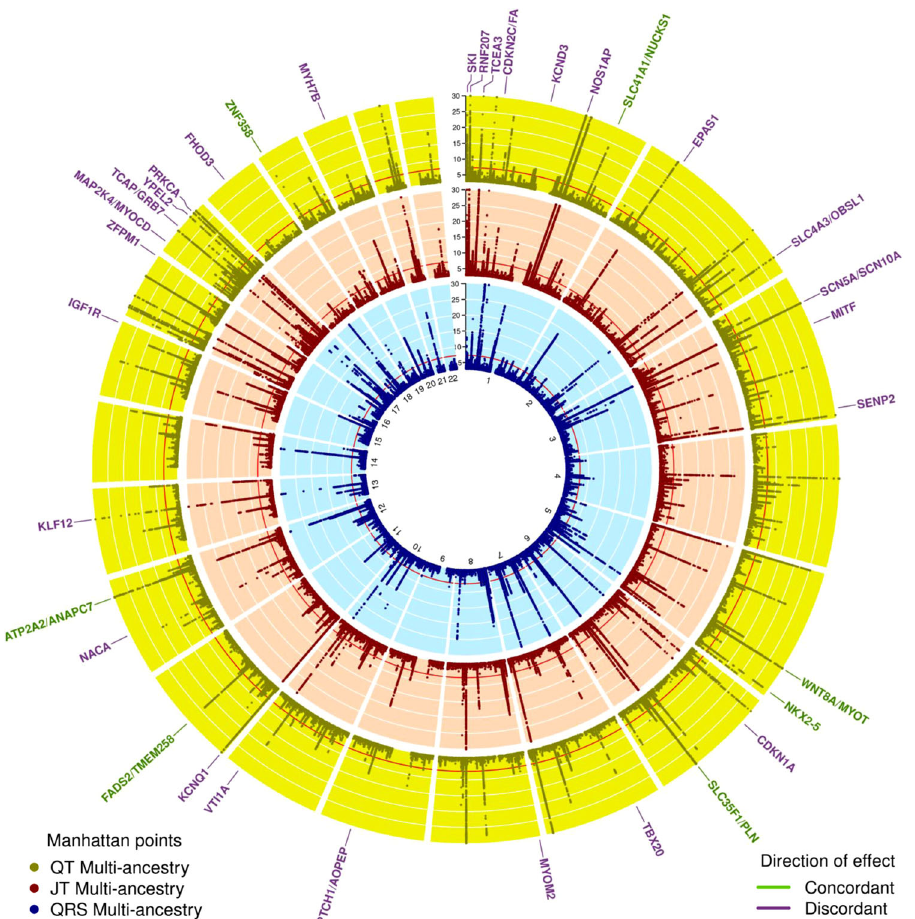
Fig. 3 | Circular Manhattan plot for QT, JT, and QRS multi-ancestry meta-ana- lyses. Circular Manhattan plots for QT (outer, yellow), JT (middle, red), and QRS (inner, blue) multi-ancestry GWAS linear regression meta-analyses. The Y -axis has been restricted to -log10 P -value < 30. Two-sided P -values are reported. A Bonferroni-corrected threshold (<5×10 − 8 ) was used to declare signi fi cance. Over- lappingJTandQRSlociarelabeledwiththemostlikelycandidateatthelocuscolor